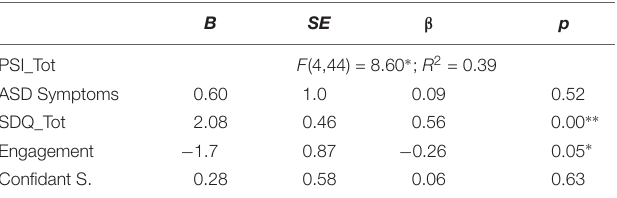
TABLE 3 | Multiple regression analysis of ASD symptoms, SDQ, engagement, and confidant support predicting parenting stress in the ASD group.